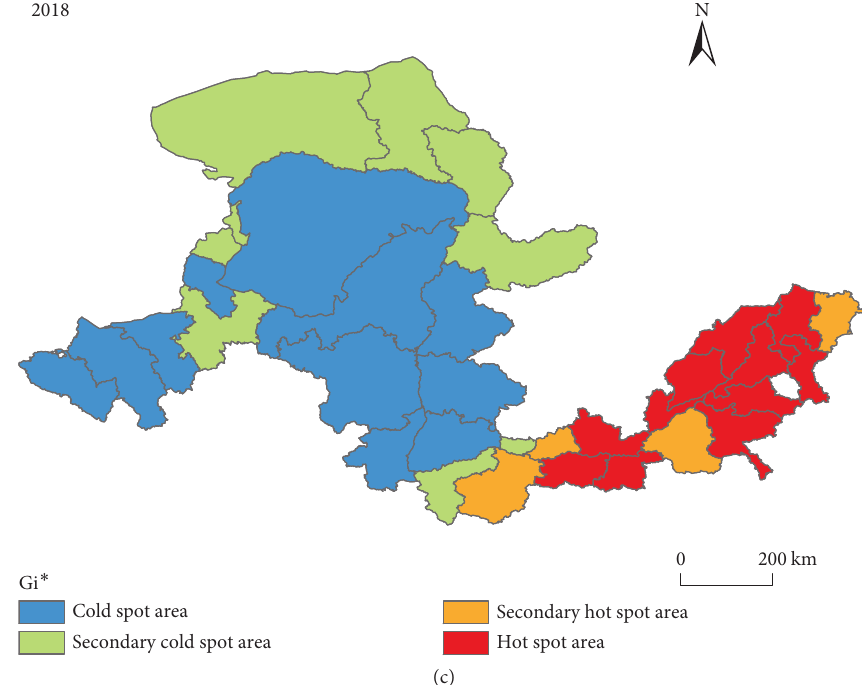
Figure 3: Spatial distribution of cold and hot spots of IGD in YRB in 2012, 2015, and